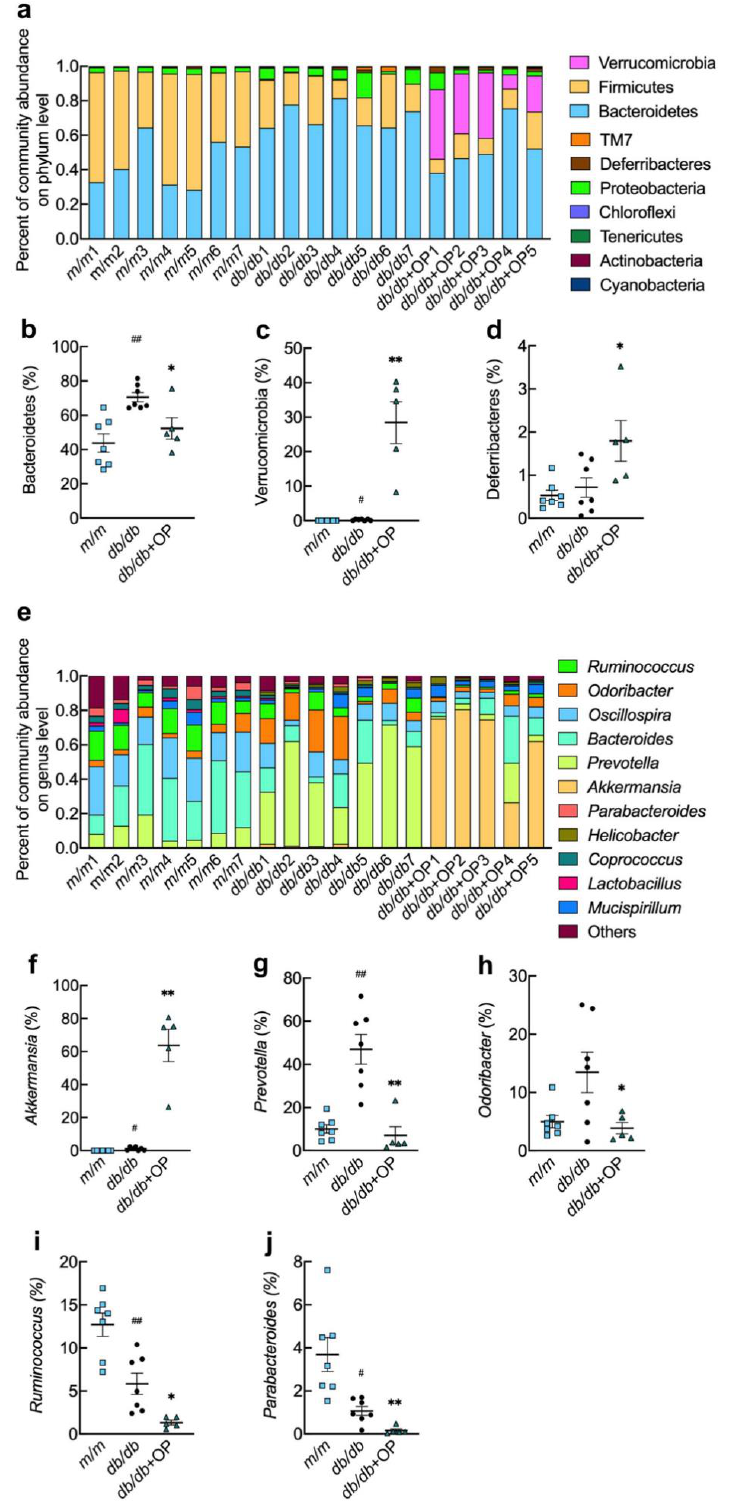
Figure 5. OP treatment changed the gut microbiota composition in db / db mice. ( a ) The relative abun- dance of intestinal microorganisms at the phylum level; ( b – d ) The relative abundance of Bacteroidetes , Verrucomicrobia , and Deferribacteres ; ( e ) The relative abundance of intestinal microorganisms at the genus level; ( f – j ) The relative abundance of Akkermansia , Prevotella , Odoribacter , Ruminococcus , and Parabacteroides . # p < 0.05, db / db versus m / m ; ## p < 0.01, db / db versus m / m .* p < 0.05, db / db + OP versus db / db ; ** p < 0.01, db / db + OP versus db /